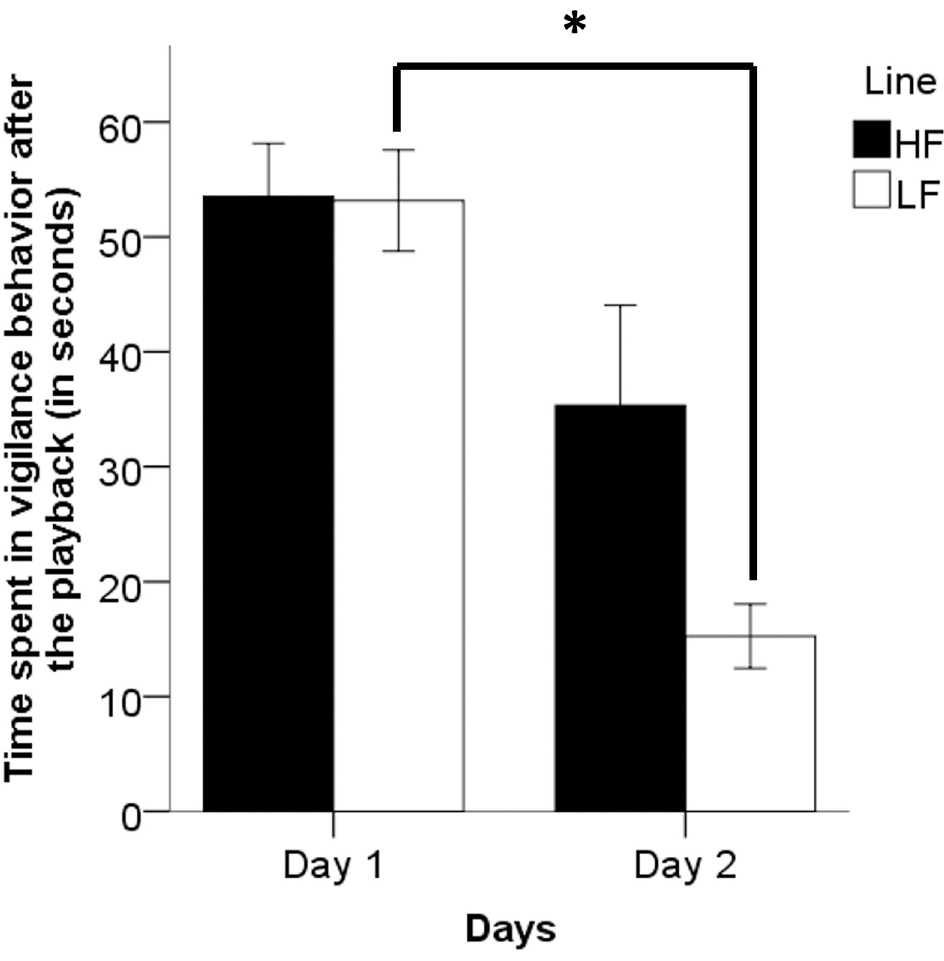
Fig 3. Time spent in vigilance behavior (in seconds), after the playbacks and over testing days (Day 1 and 2, without taking into account the playback call type), for Red Junglefowl hens selected for High (HF) and Low fear (LF) of humans. Mean ± SD are given. (n High = 6 pairs, n Low = 6